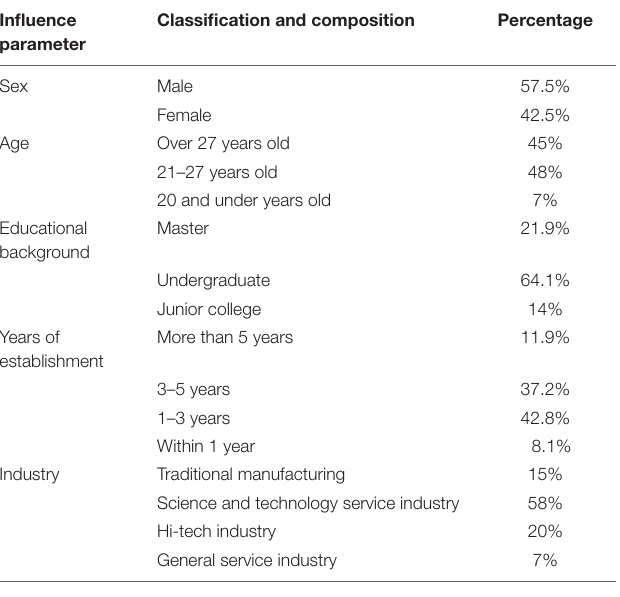
TABLE 3 | Demographic characteristics of the research samples.